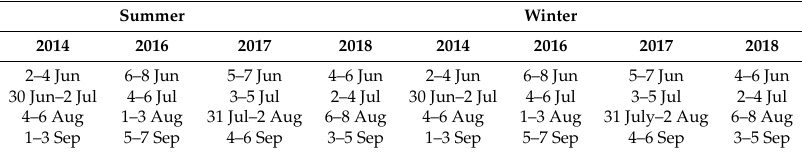
Table 4. Testing data for summer and winter months.